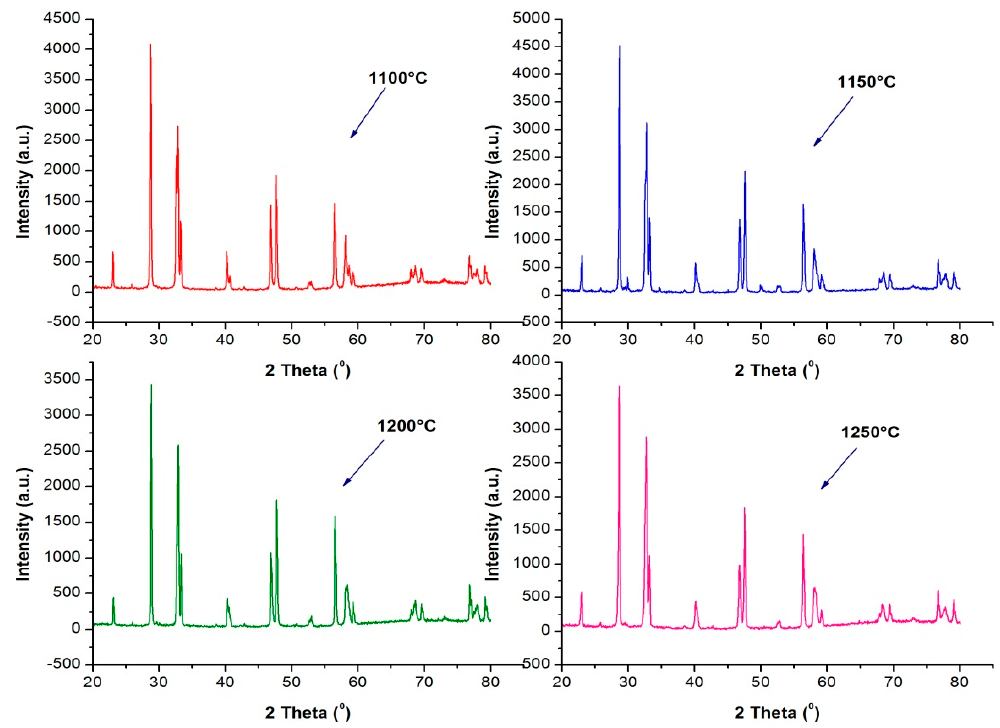
Figure 11. XRD patterns of the LSM cathode, with respect to the firing temperature.